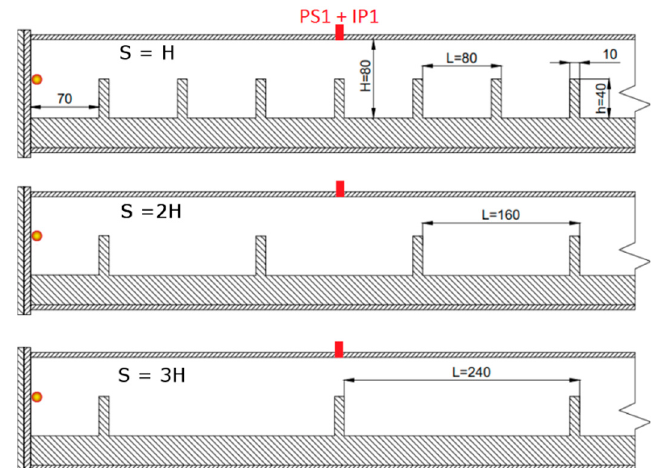
Figure 2. Detonation tube cross-section for different obstacles spacings. Orange point marks the ignition point position, red rectangle marks first pair of sensors placement: pressure sensor (PS1) and ion probe (IP1); both sensors at 320 mm axial distance from the ignition point.